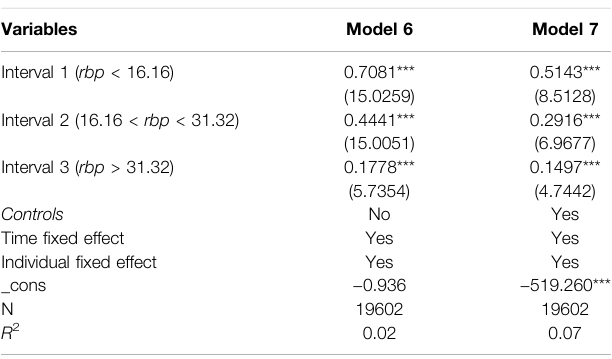
TABLE 6 | Results of threshold regression. Variables Interval 1 ( rbp <